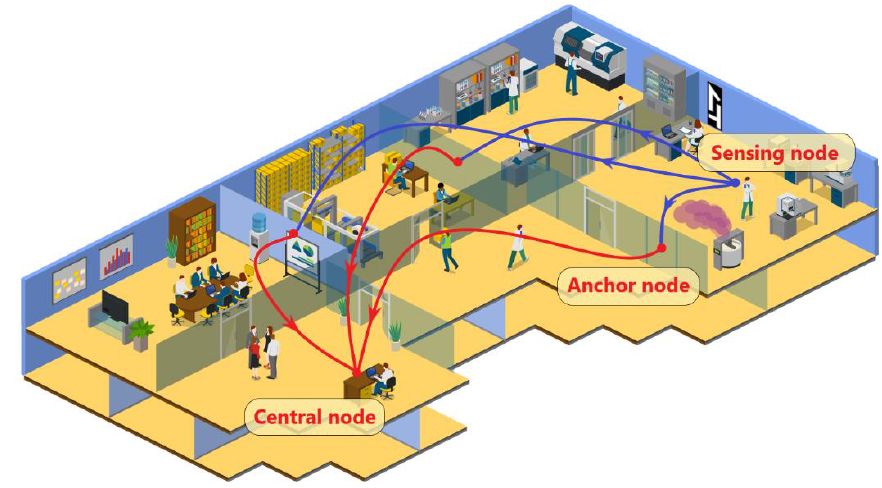
Figure 1. Representation of the WSN proposed, with the localization functionality, applied in a generic indoor environment.